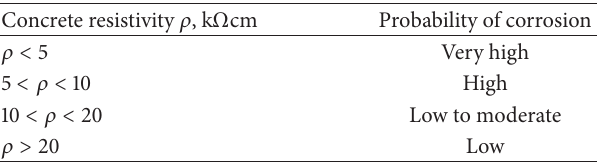
Table 2: Dependence between concrete resistivity and corrosion probability